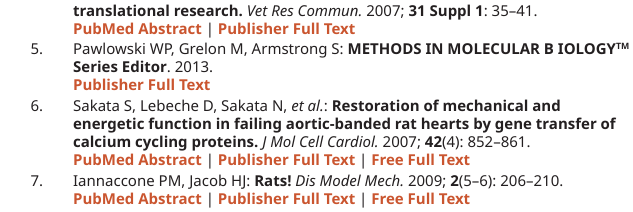
Figshare: A simple Adeno Associated Virus (AAV) -Based Approach for The Generation of Cardiac Genetic Models in Rats_Fig 3, https://doi.org/10.6084/m9.figshare.13148663.v1 29 This project contains the following underlying data: TIF format Figshare: A simple Adeno Associated Virus (AAV) -Based Approach for The Generation of Cardiac Genetic Models in Rats_Fig 4, https://doi.org/10.6084/m9.figshare.13148678.v2 30 This project contains the following underlying data: - Raw GFP signal images as shown in Figure 4 in TIF format Figshare: A simple Adeno Associated Virus (AAV) -Based Approach for The Generation of Cardiac Genetic Models